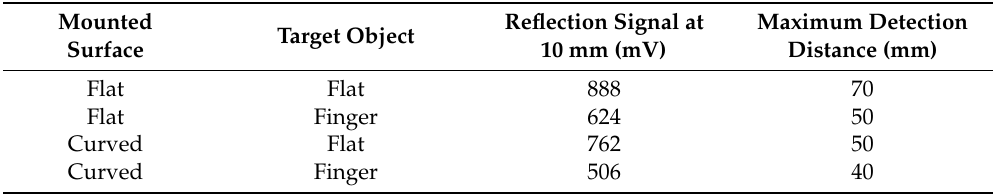
Figure 22. Distance measurement signal of the transparent CMUTs mounted on flat and curved surfaces to detect a flat target and a finger. Table 3. Reflection signals and maximum detection distances of transparent CMUT obtained on flat and curved surfaces for flat target and finger.